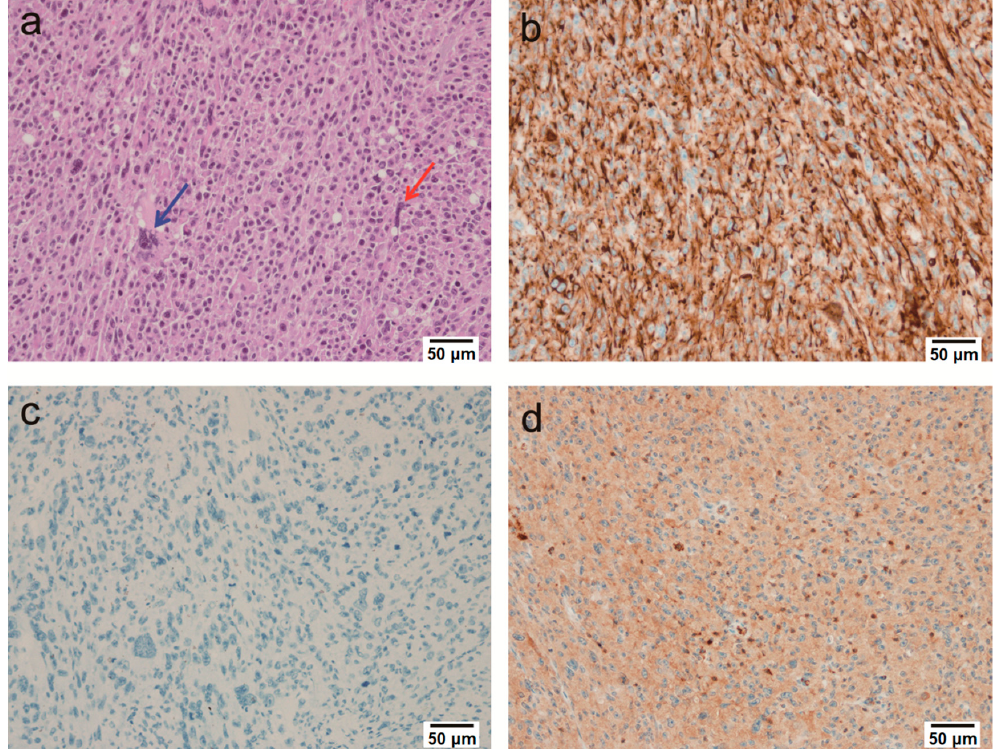
Figure 2. Microscopic analysis of prostate tumor tissue: ( a ) Tumors were highly undifferentiated and pleomorphic. Some of the tumor cells appeared to be epithelial or mesenchymal in origin. The poorly differentiated cells had a slightly basophilic cytoplasm and a round or oval shape. Multinucleated giant cells were occasionally visible (blue arrow). Bizarre cells with a large and pale cytoplasm and with prominent nuclei were also observed (red arrow) (H & E, 200×); ( b ) Positive immunoreactivity for pan-cytokeratin was seen (200×); ( c ) Immunostaining without the PSA primary antibody was negative 200×); ( d ) Immunostaining for PSA was positive (200×).